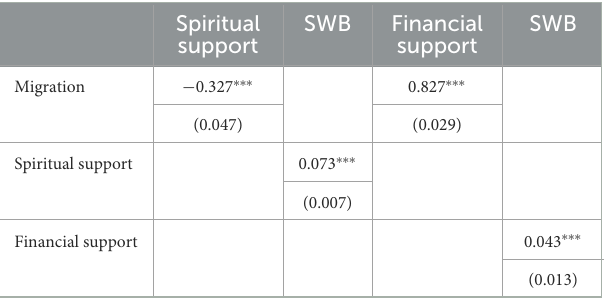
TABLE 4 Results of the mechanism test.